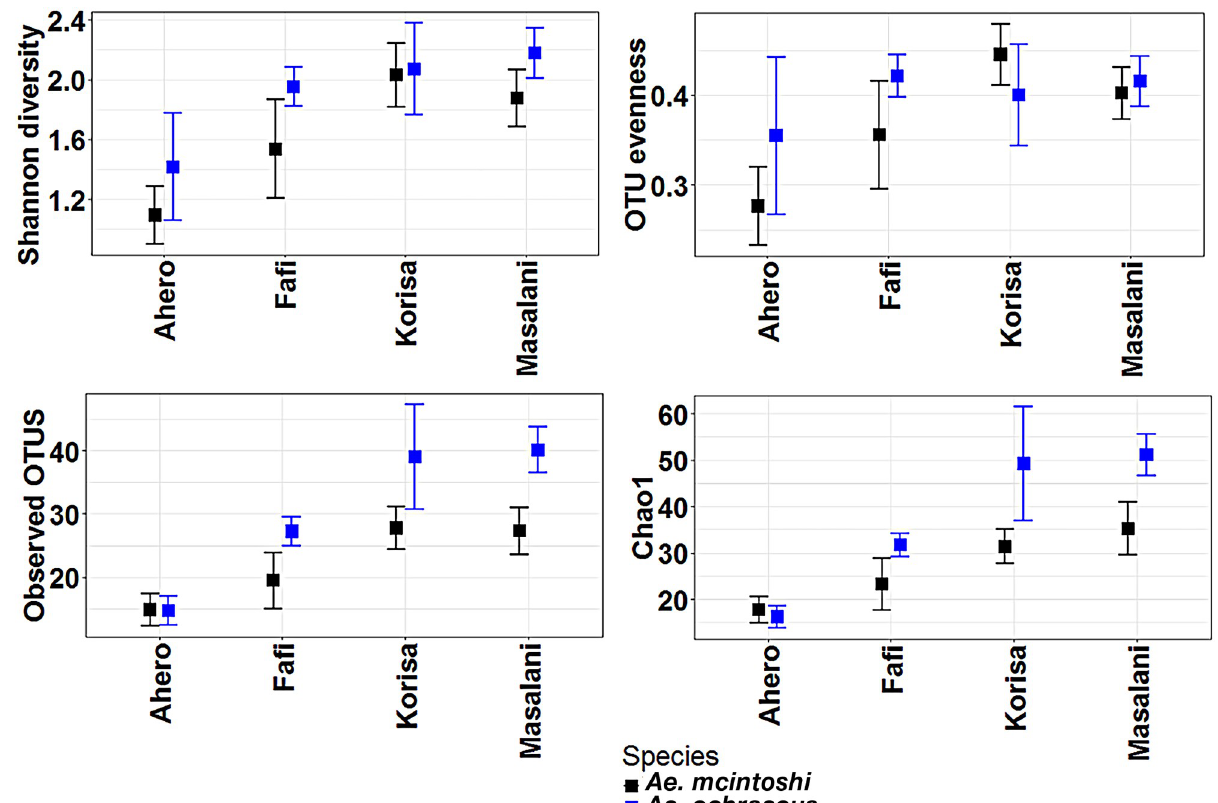
Fig 4. Biodiversity estimators of Aedes mcintoshi and Aedes ochraceus microbiota (mean ± standard error).